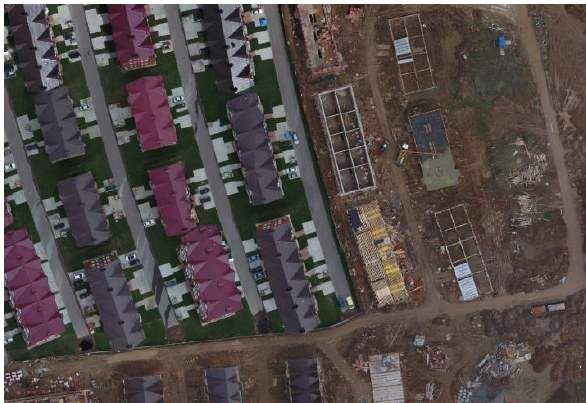
Figure 13. State of the site as of May 7,